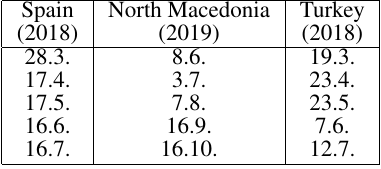
Table 1. Multitemporal data - selected